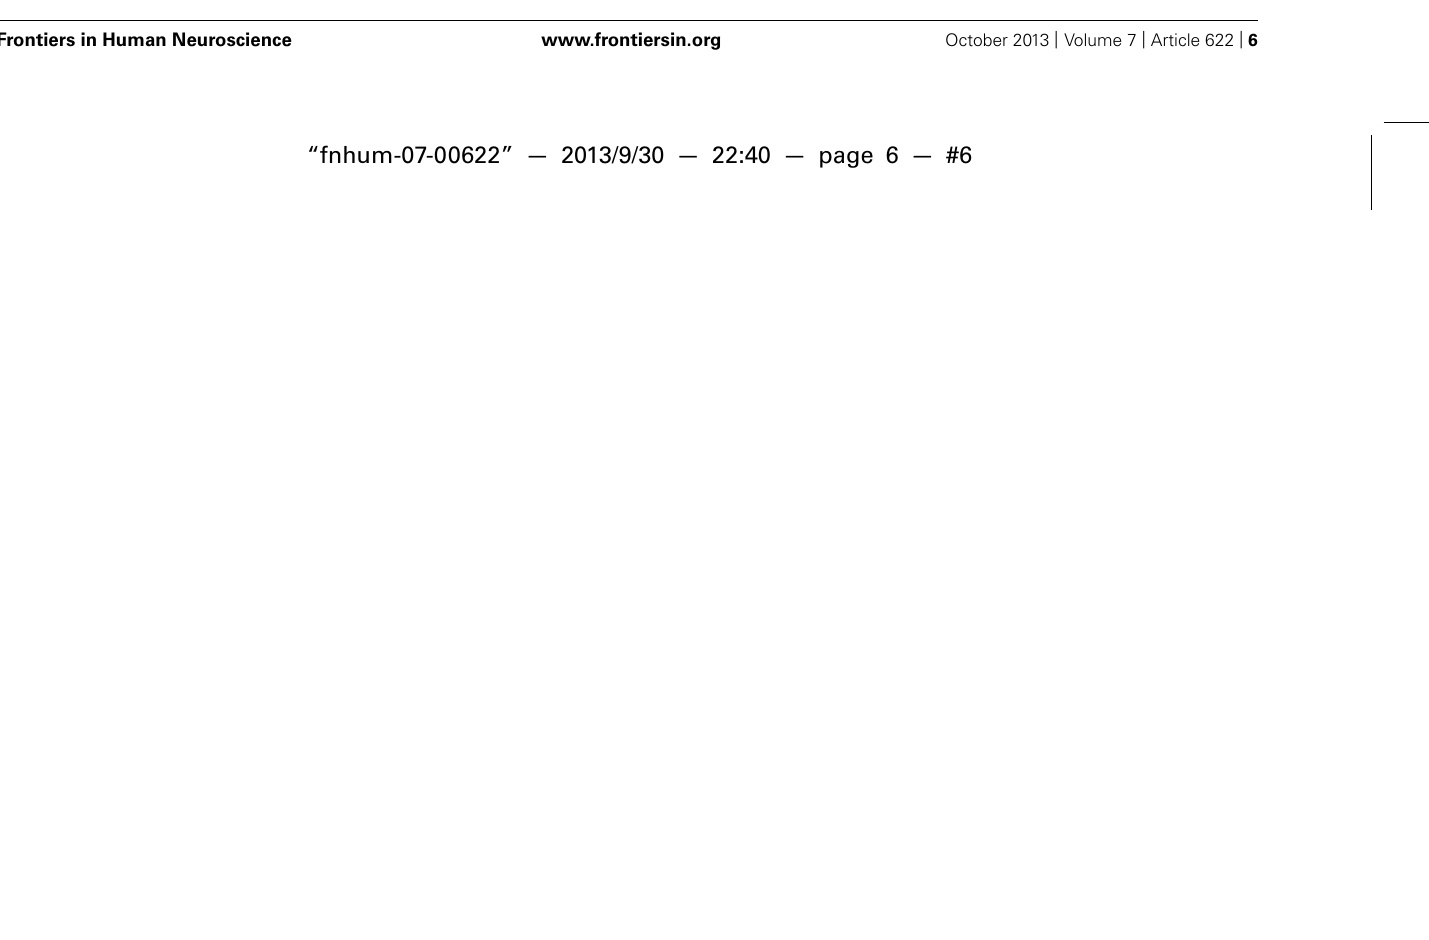
A positive difference score indicates that Communicators performed better in the TARGETED setting, a negative score that Communicators performed better in the NON-TARGETED setting. To correct for individual differences in general performance on the Taboo game, a model to account for communicative success during the targeted setting compared with the NON-TARGETED setting was created. The difference in accuracy scores between the two conditions was positively driven by the Communicator’s general intelligence as indexed by the Raven’s APM. Neither the EQ, nor any of the IRI subscales could account for the difference in success across the communicative